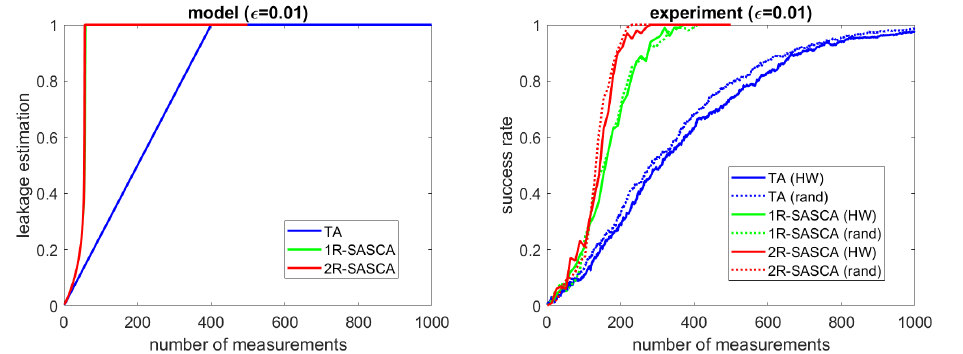
Figure 9: Leakage bounds and success rates of experimental SASCA with up to two rounds against an unprotected AES implementation in a known plaintext scenario